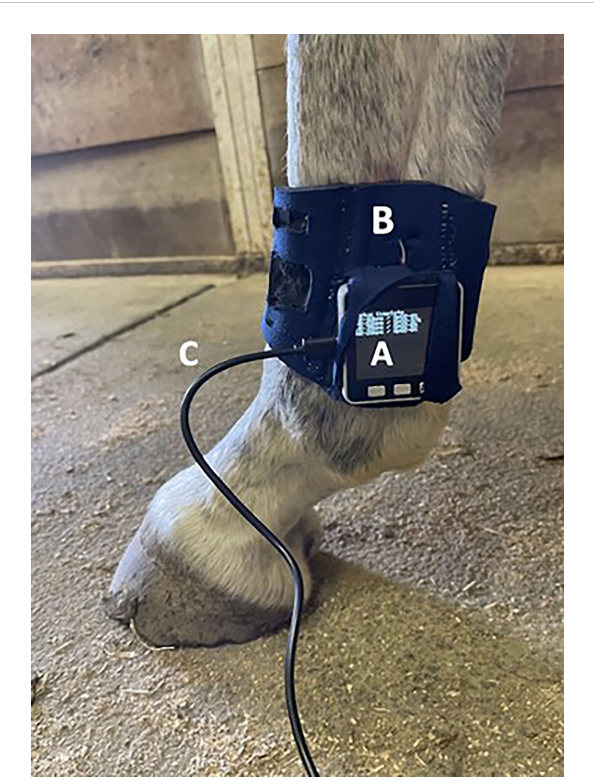
FIGURE 1 The PPG-based heart rate sensor attached to a hind limb during data collection. (A) M5Stack GRAY kit (M5Stack, Guangdong, China), which has an ESP-32 core and integrated OLED screen used for data integration and visualization. (B) Attachment of the sensor to the horse using fl exible neoprene with a Velcro strap. (C) USB charging cable connected to an external battery